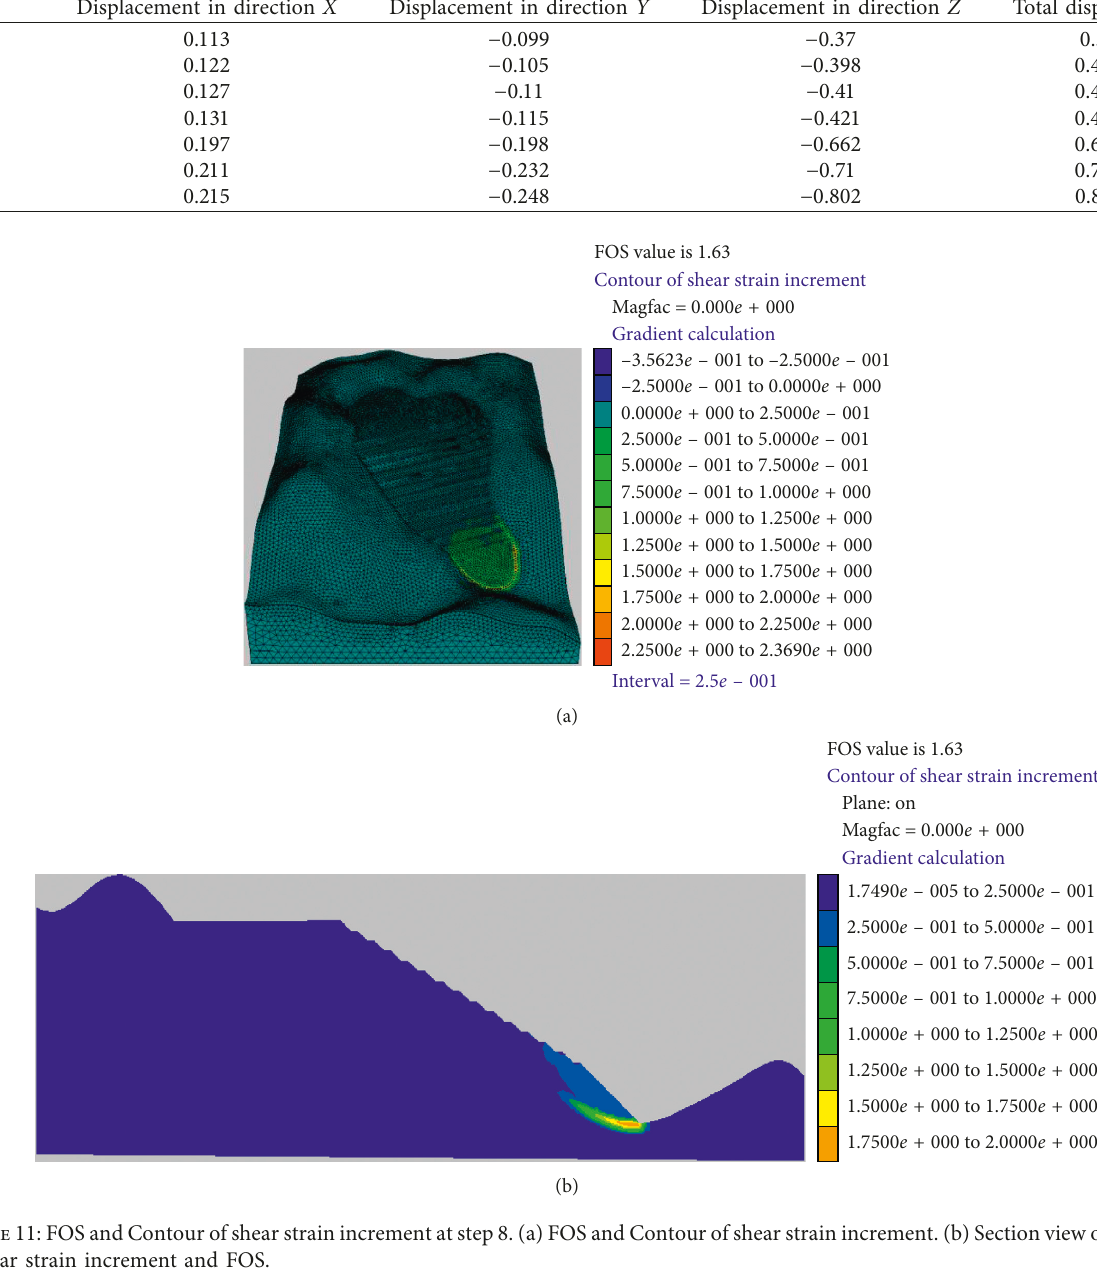
Figure 11: FOS and Contour of shear strain increment at step 8. (a) FOS and Contour of shear strain increment. (b) Section view of Contour of shear strain increment and